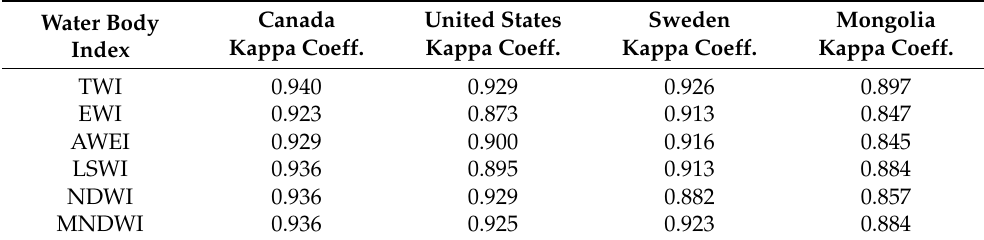
0.90.9150.930.9450.960.975